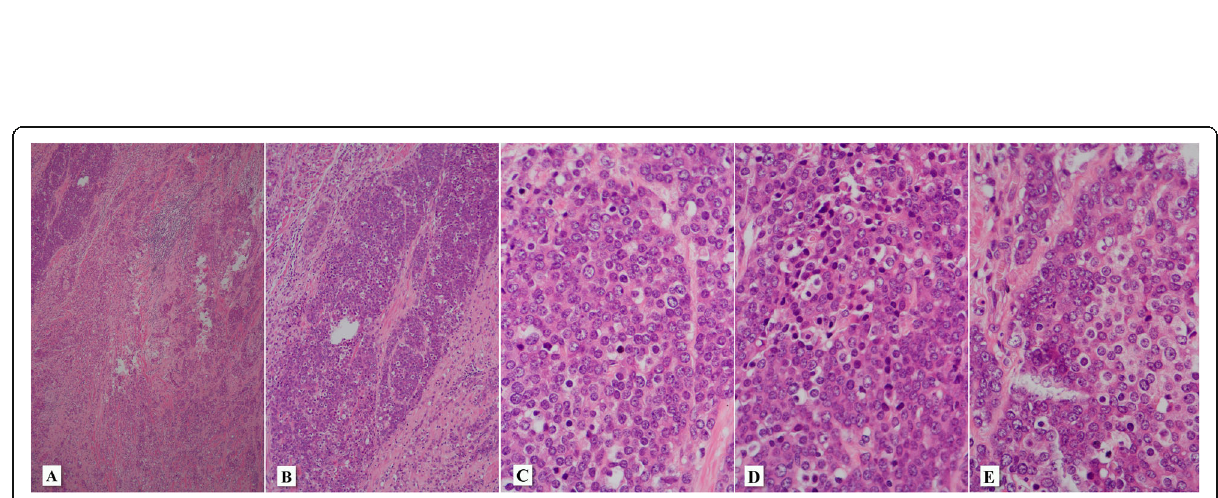
Fig. 7 A minute 3.5-mm focus of poorly differentiated carcinoma. A solid proliferation with numerous apoptotic bodies and nuclei alternating prominent nucleoli or stippled chromatin. Hematoxylin and eosin stain: A (40x), B (100x) and C , D and E